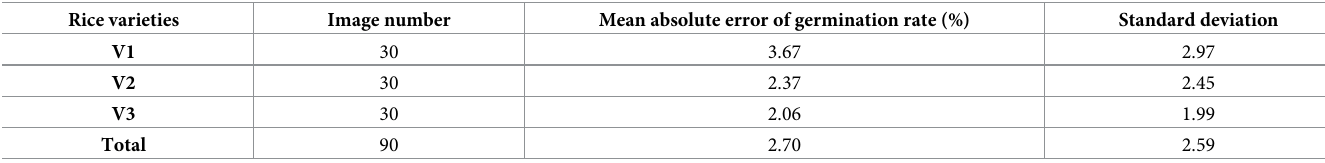
Table 2. The mean absolute error of germination rate for the three rice varieties. Rice